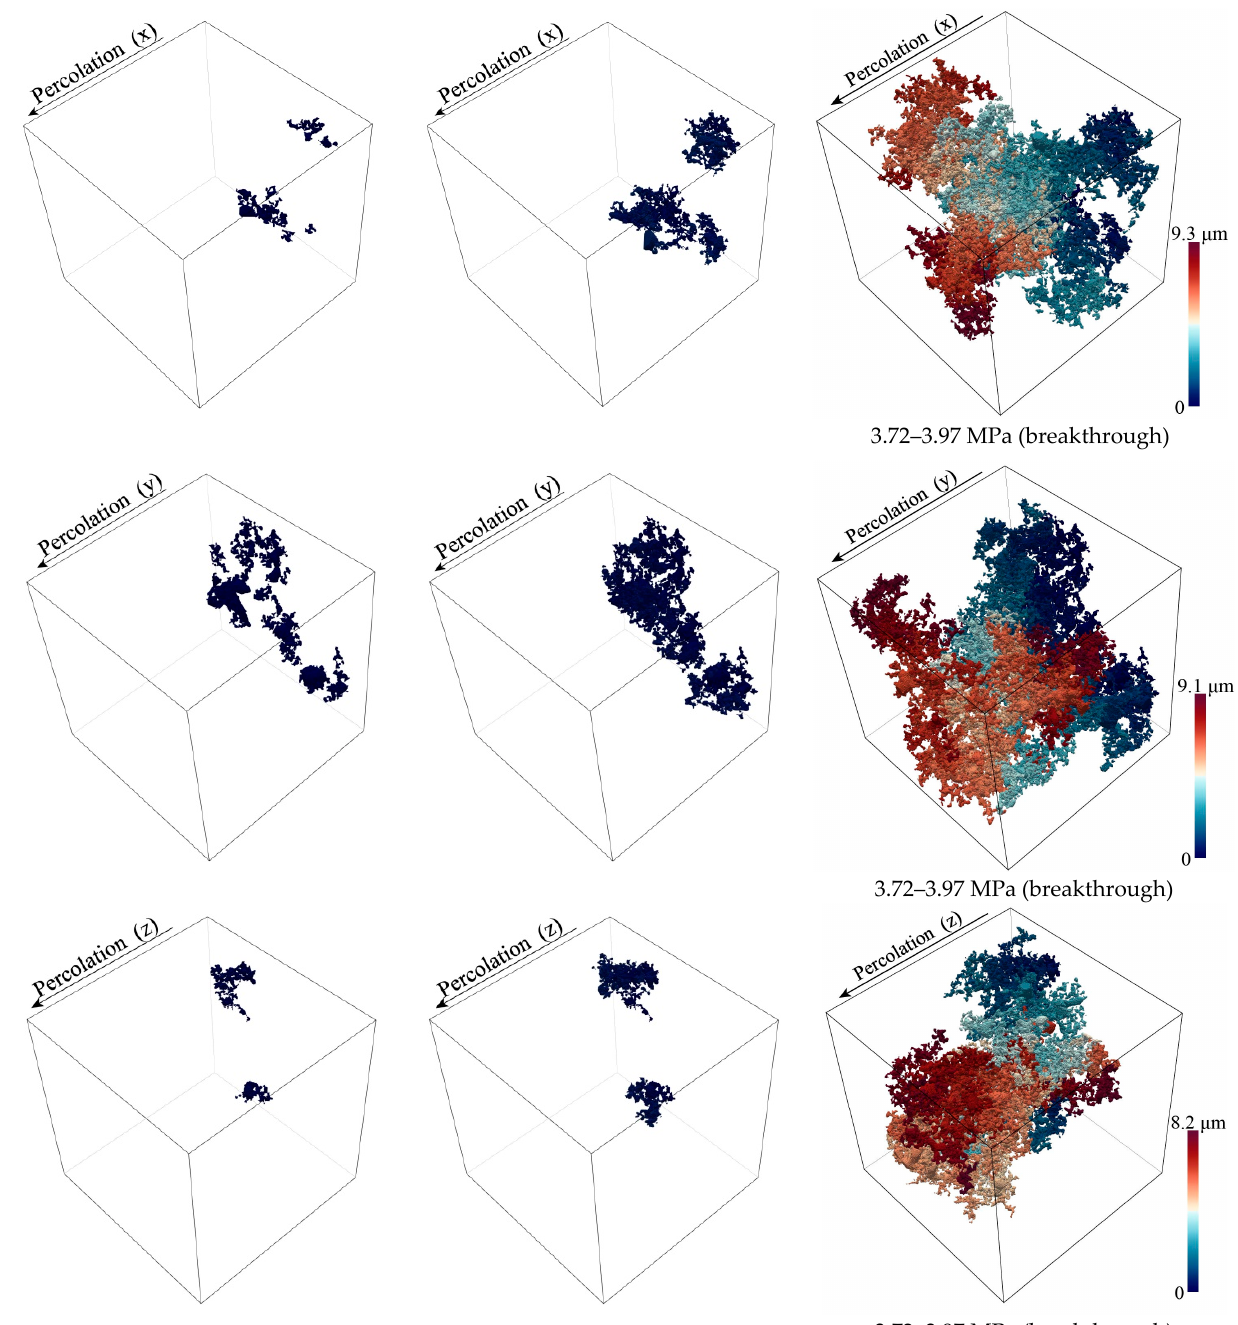
Figure 15. Gas migration in the Boom clay model.